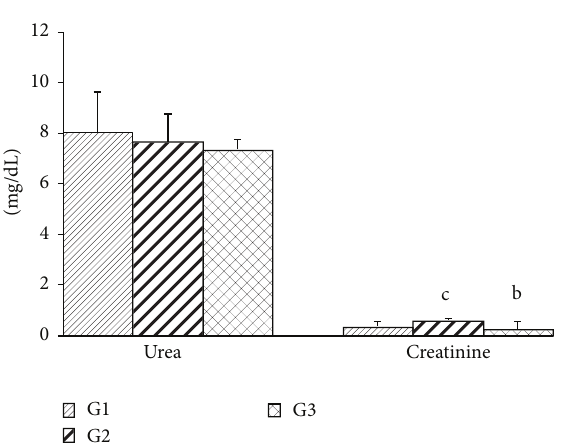
Figure 2: Serum urea and creatinine levels after 30 days for all experimental groups. Values are given as the mean ± SD for groups of eight animals each. a Significantly different from G1; 𝑃 ≤ 0.05 ; b significantly different from G2; 𝑃 ≤ 0.05 ; c significantly different from G3; 𝑃 ≤ 0.05 . G1: untreated control; G2: treated with geraniol; G3: treated with essential oil.